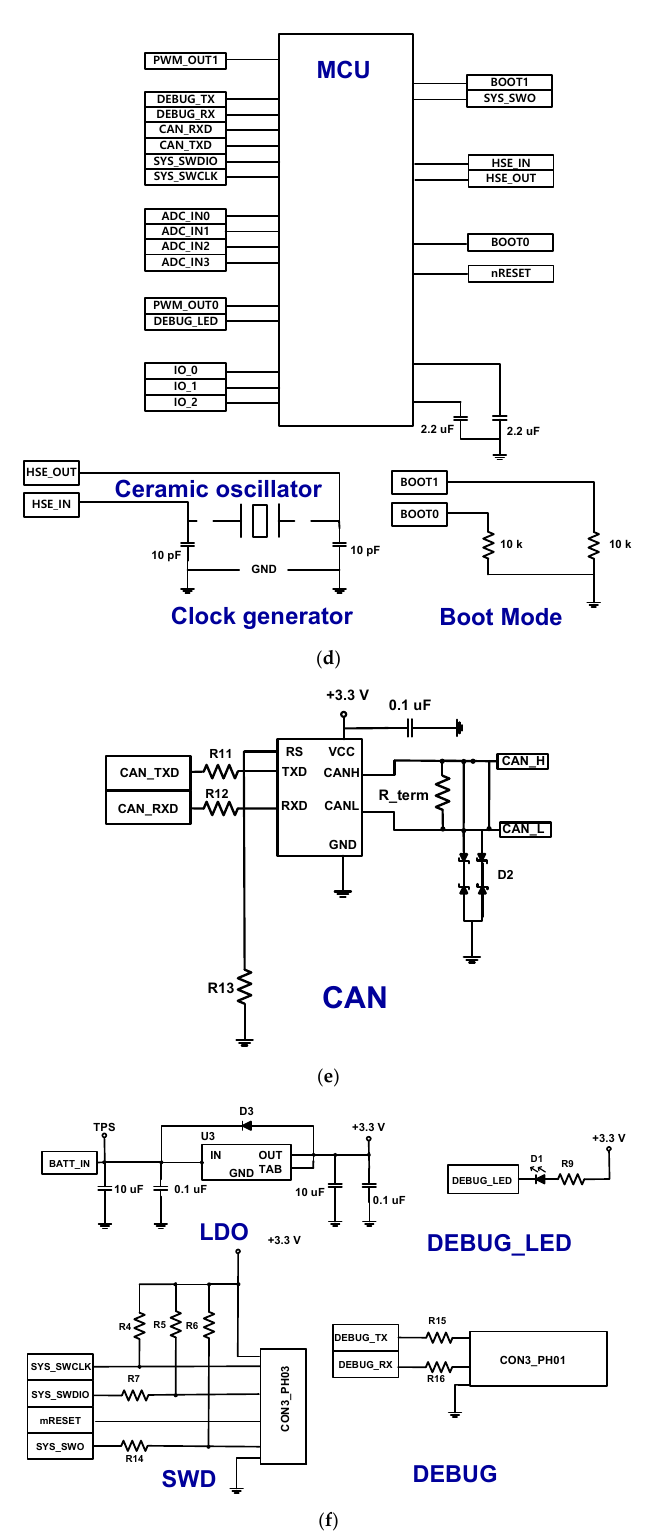
Figure 4. ( a ) Configuration of the wireless ultrasound surgical system (WUSS), ( b ) block diagram of the generator instrument, and ( c ) designed transimpedance amplifier circuit with transformer and harmonic termination parts. Circuit diagram of the ( d ) main microcontroller unit (MCU), ( e ) controller area network (CAN) communication driver, and ( f ) low-drop out (LDO), serial wire debug (SWD), and debugging